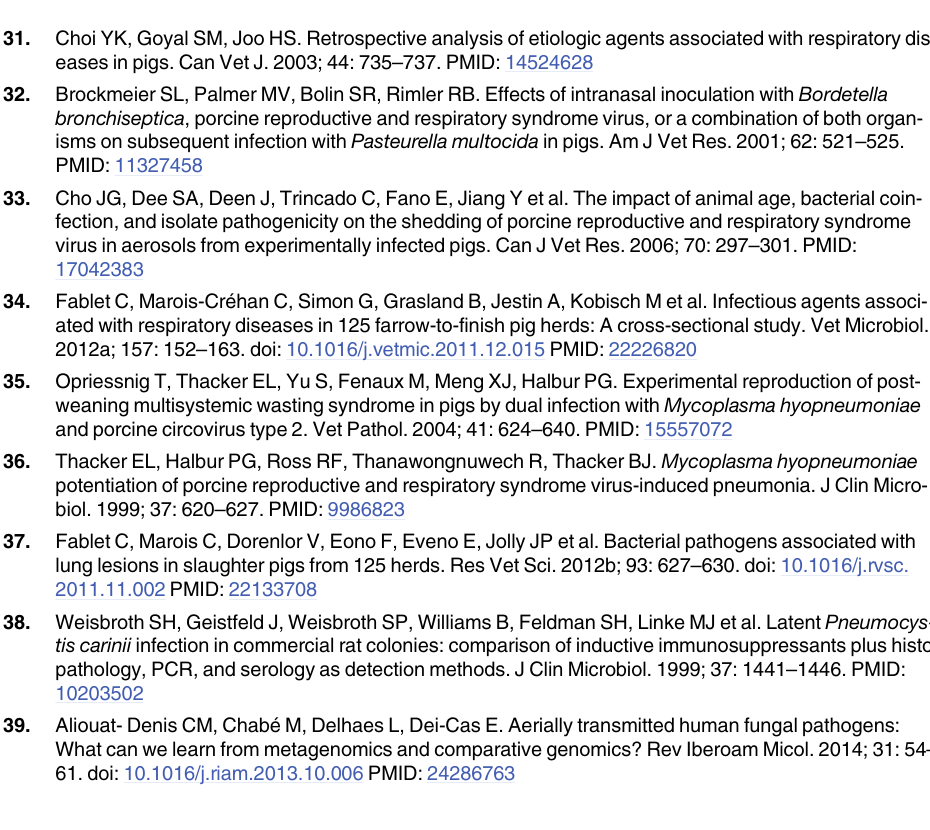
PLOS ONE | DOI:10.1371/journal.pone.0158479 July 18,